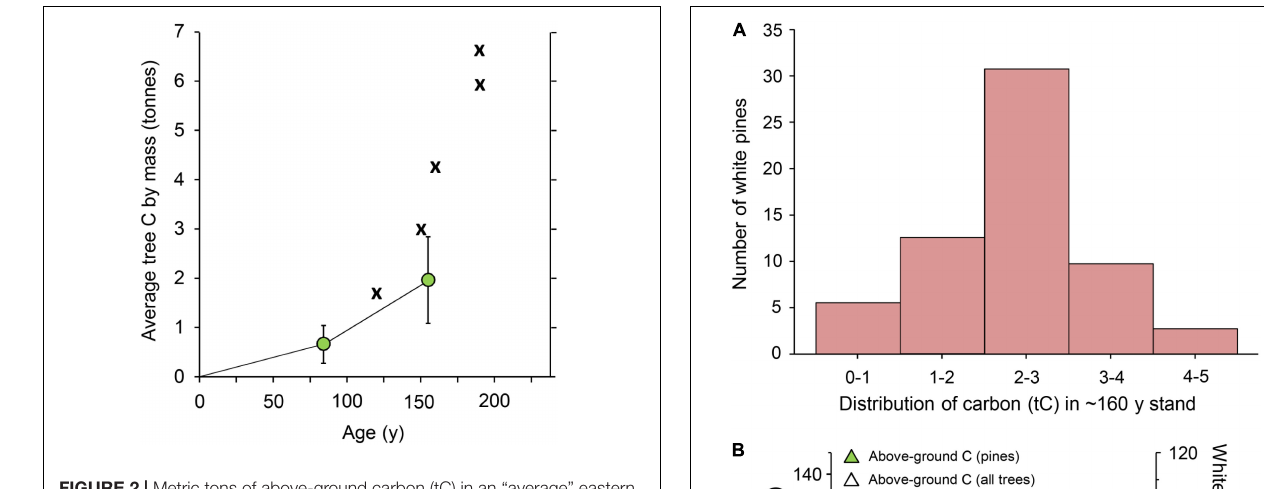
FIGURE 2 | Metric tons of above-ground carbon (tC) in an “average” eastern white pine in a measured research acre (green locants) and in five individual trees measured directly on site at three separate locations in Massachusetts. Average tC and standard deviation is based on pines in a stand at ∼ 80 years (0.66 ± 0.38 tC) and ∼ 160 years (1.93 ± 0.73 tC) as described in the text. Direct measurement of tC is shown for individual trees in western Massachusetts at these ages and locations (the centers of the X symbols indicate the data points): ∼ 190 years: MSF #1 and #2, Monroe State Forest; ∼ 160 years: Pine #58, Mohawk Trail State Forest; more details of Pine #58 shown in Figure 1 ; ∼ 150 years: Totem, Northampton, MA; ∼ 120 years: BB #2, Broad Brook, Florence, MA.